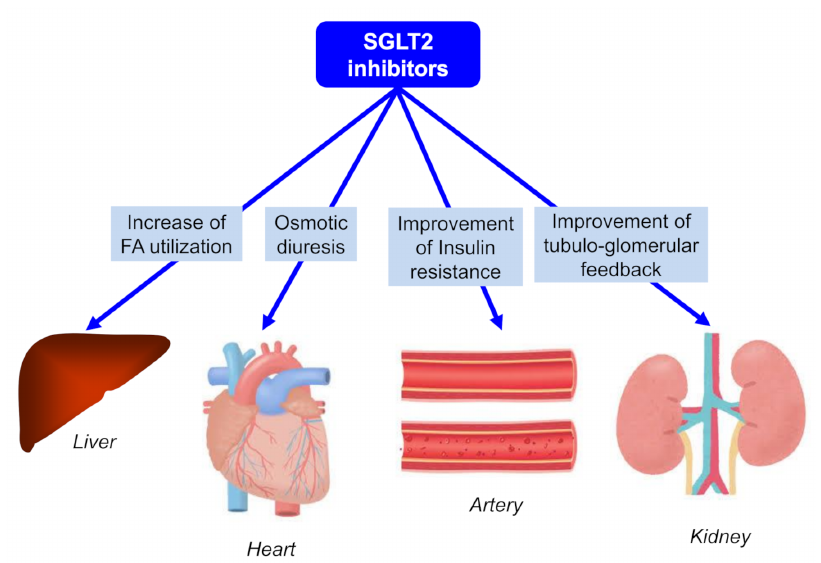
Figure 4. Unique multi-organ protective effects beyond the hypoglycemic effect of SGLT2